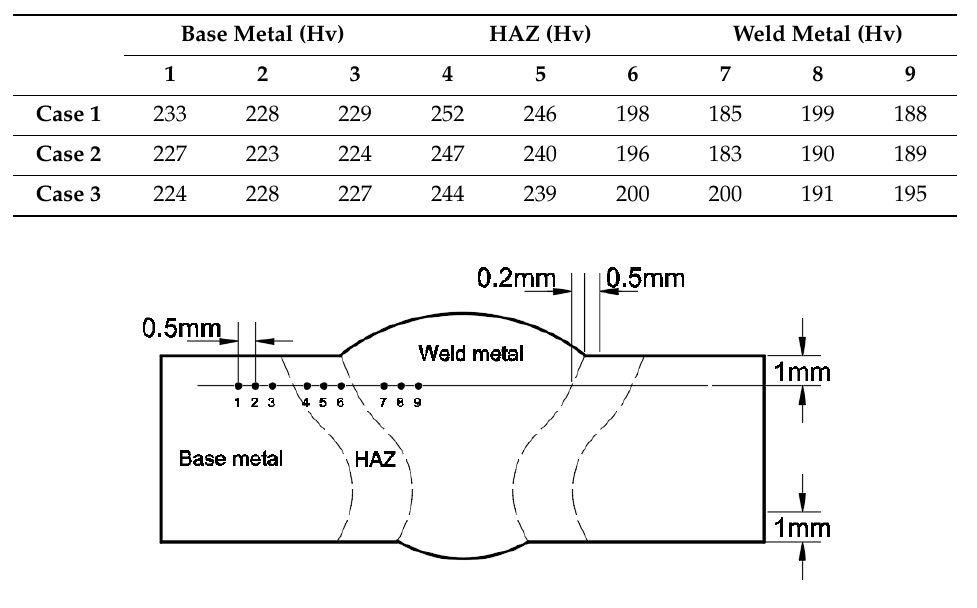
Figure 13. Measurement points of hardness test.